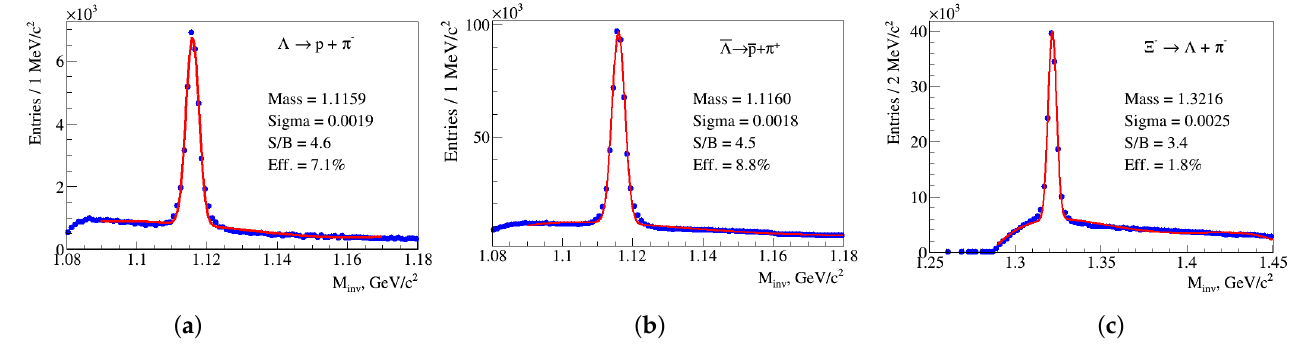
Figure 3. Reconstructed invariant mass spectra of hyperon decay products: ( a ) Λ → p + π − , ( b ) Λ → p + π + , ( c ) Ξ − → Λ + π − . Results for different numbers of processed events are shown. Histograms are fitted to a sum of a Gaussian and a polynomial. The numbers in the legends present mean and sigma of the Gaussian as well as signal/background ratio and signal reconstruction efficiency, where the signal and background are calculated within ± 2 σ interval of the peak position and efficiency is taken with respect to all hyperons produced within 50 cm of the interaction